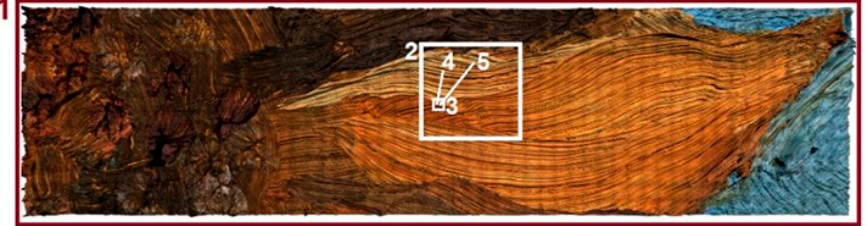
Figure 7. The measurement scheme.